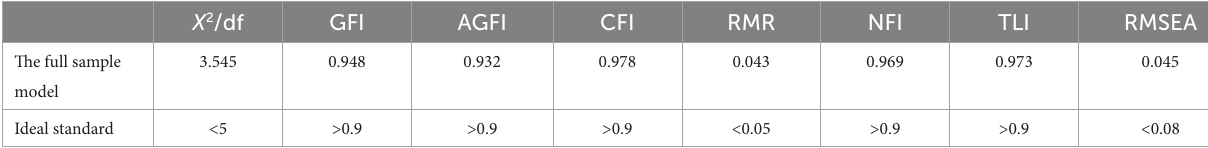
TABLE 2 The fitness fitting index of the full sample model.